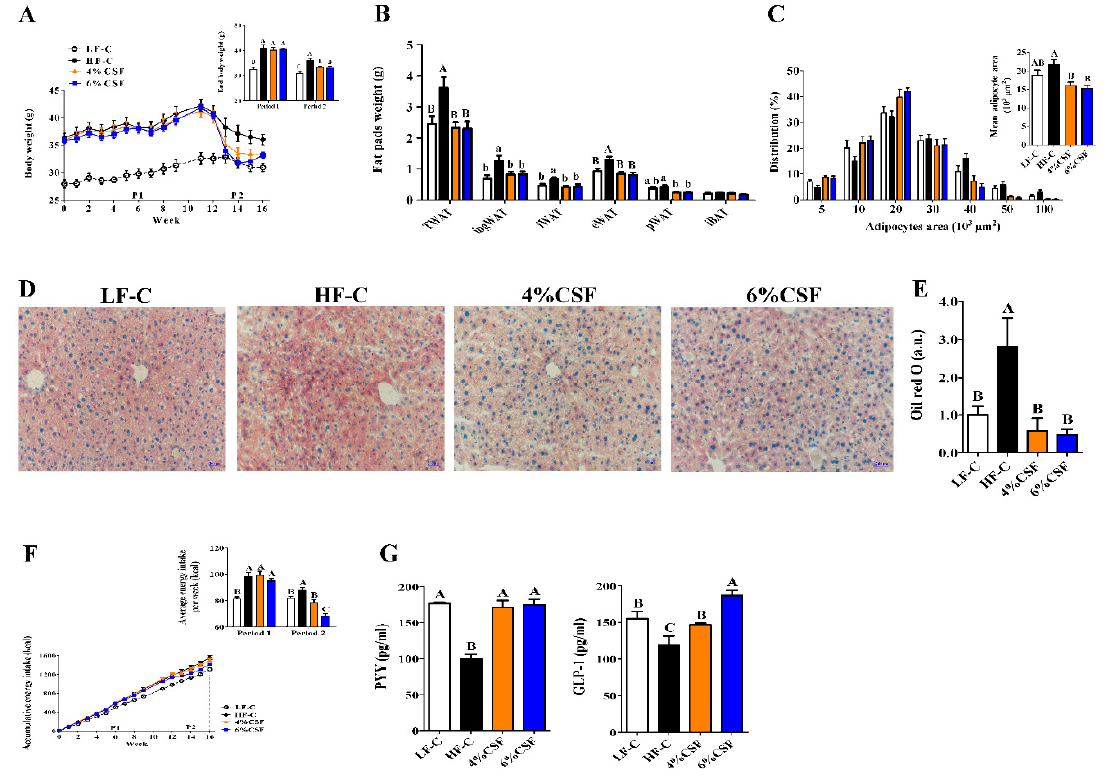
Figure 1. Combined soluble fiber (CSF) improves the adiposity in diet-induced obese (DIO) mice by regulating appetite under normal chow basal diet (NCD) but not high-fat diet (HFD). ( A ) Body mass over time and final body weight per period (n = 7). ( B ) Weight of total white adipose tissue (TWAT), inguinal white adipose tissue (ingWAT), interscapular WAT (iWAT), epididymal WAT (eWAT), perirenal fat (pWAT) and interscapular brown adipose tissue (iBAT) (n = 6–7). ( C ) Adipocyte size distribution (n = 7). ( D , E ) Fat in the liver (n = 6–7) was observed by oil red staining ( D ) and quantified by image analysis at 200 × magnification ( E ). ( F ) Accumulative energy intake (n = 7). ( G ) PYY and GLP-1 levels in the 2-h postprandial blood during period 2 (n = 6–7). Data are expressed as mean ± SEM. Statistical significance was assessed by Tukey’s test for multiple comparisons. ab means in the same bar without a common letter di ff er at p < 0.05; ABC means in the same bar without a common letter di ff er at p <